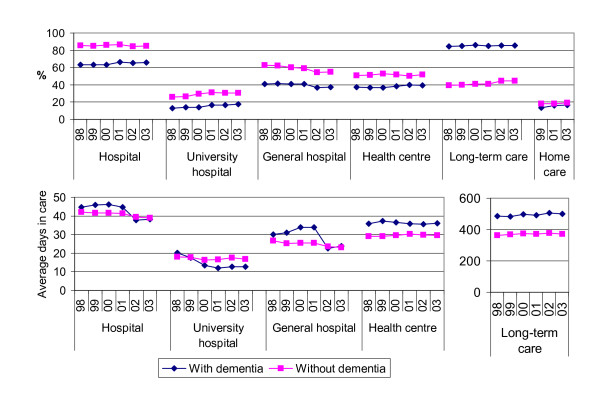
Proportions of service users and average number of days in care among those who used services in their last two years of life according to year of death. Adjusted for age and gender.